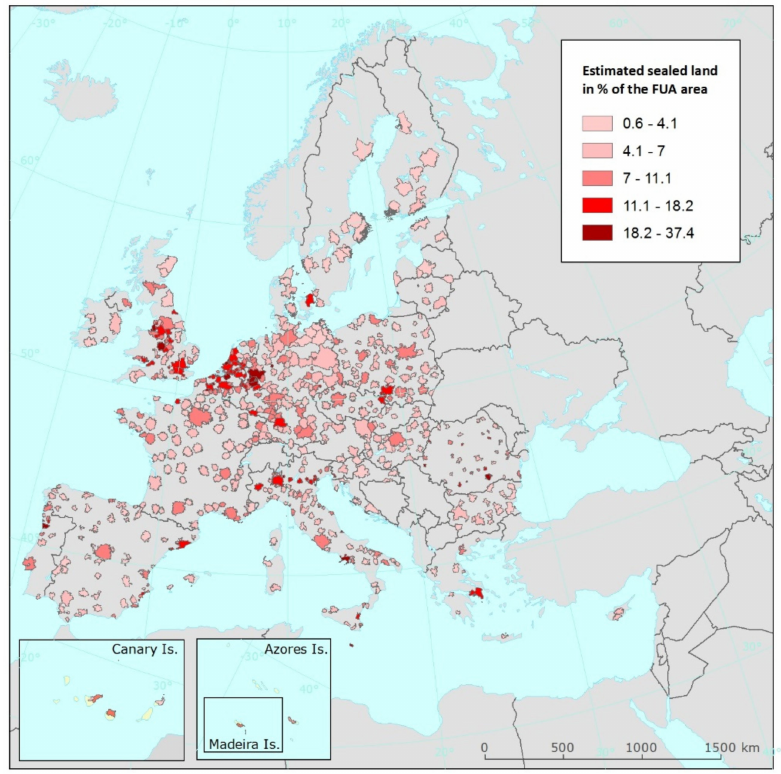
Figure 2. Estimated sealed land in % of the total area in Functional Urban Areas in